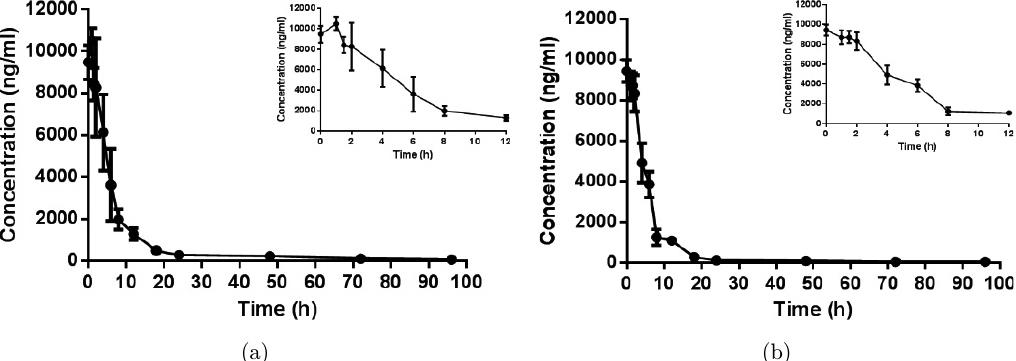
Fig. 3. Mean concentration – time pro¯le of Photocyanine in serum of male (a) and female (b) Kunming mice bearing S180 tumors ( n ¼